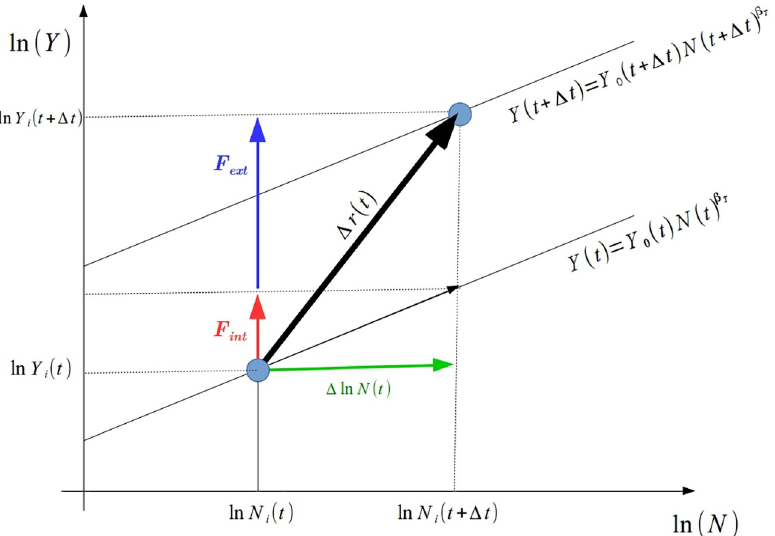
Fig 5. Plane ln Y -x-ln N , representing the “movement” of the city as a particle in a vector field. In the horizontal direction, we have the vector (green) that represents the increase in population size. In the vertical direction there is the action of two vectors: F (red), which is an extensive quantity whose magnitude is a direct response to the increment int of the population size related to an agglomeration effect between the individuals that live in this single city; and F ext (blue), which is the vector related to some external aspects, or the interaction between the individuals from this city with individuals of other cities, or some individual incorporated ability. The action of this vector field during a time interval Δ t conducts to a “displacement” Δ r ( t ) of this city (or particle) in this two-dimensional plane. The two parallel lines are given by the global system (transversal) power law (Eq (1)) in t and t + Δ t .